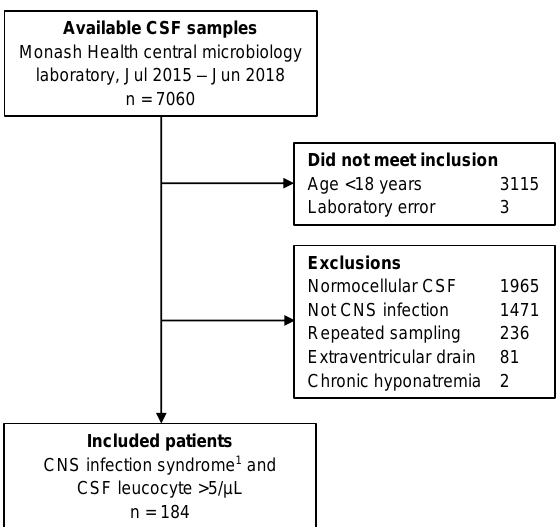
Figure 1. Study flow diagram detailing reasons for exclusion of cerebrospinal fluid (CSF) samples. The majority of exclusions were due to normal CSF leucocyte counts, followed by CSF testing for reasons other than central nervous system (CNS) infection (e.g., neurological disease). 1 meningitis or encephalitis.